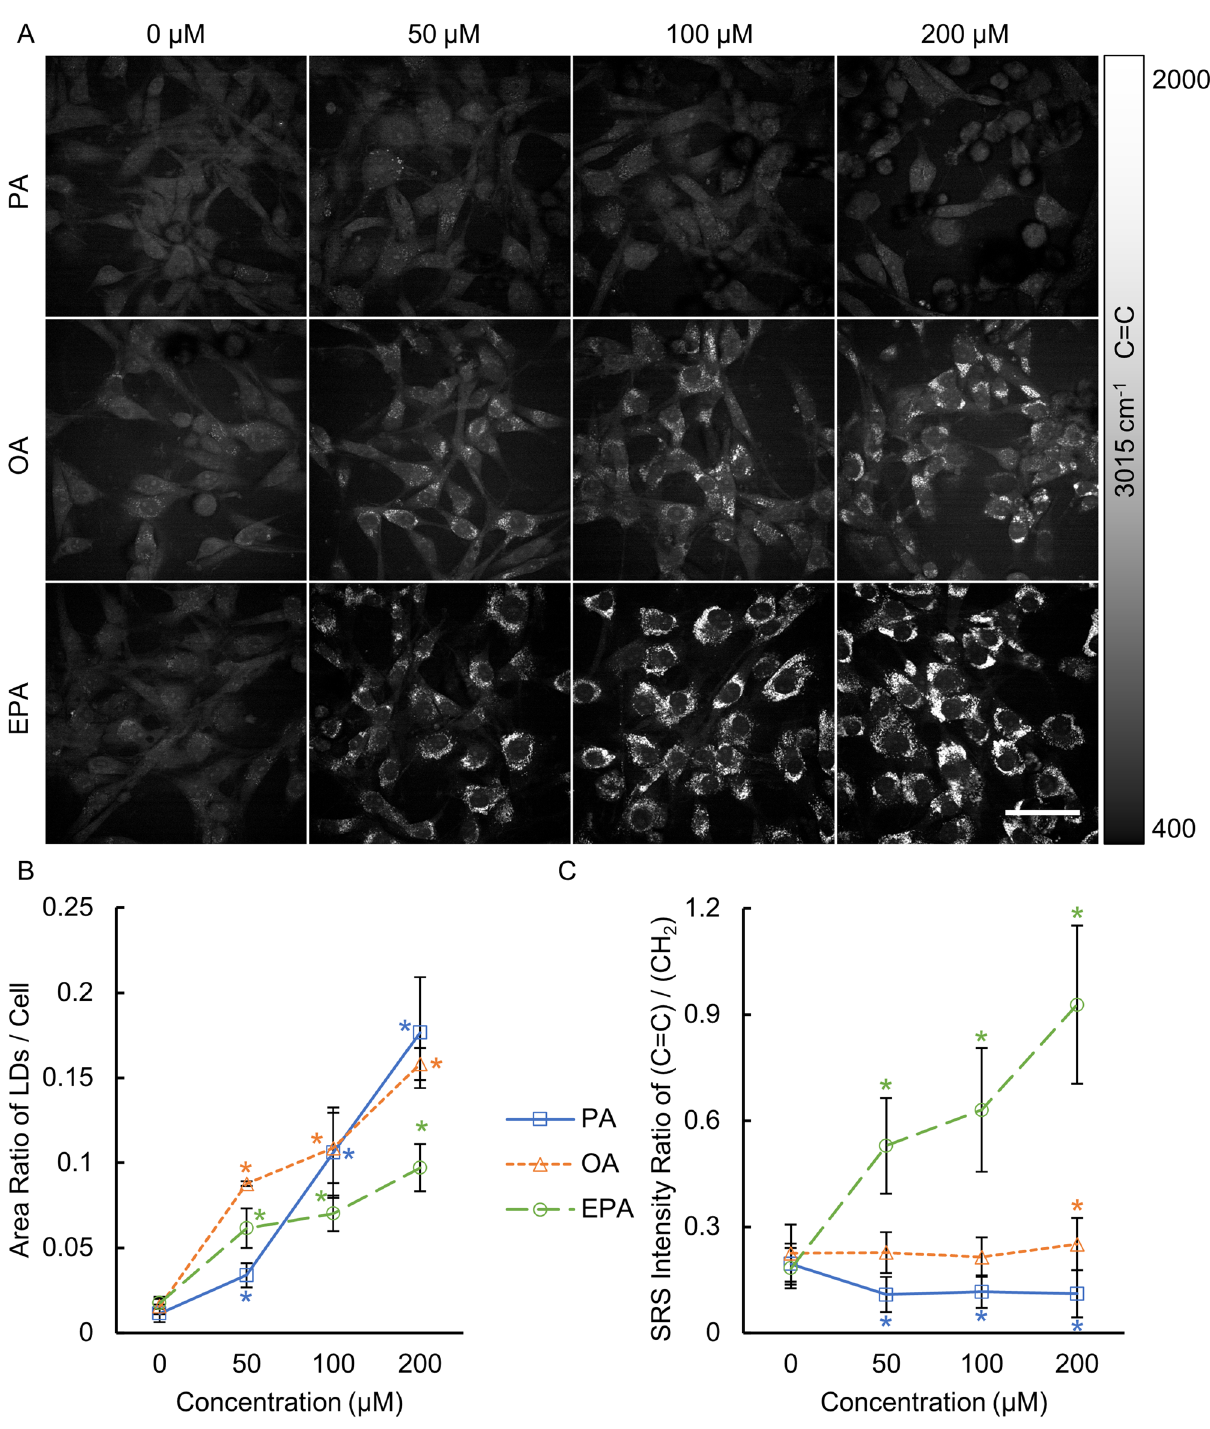
Figure 5. ( A ) SRS images at 3015 cm −1 attributed to C=C vibration with the corresponding fields of view as in Fig. 4. U87 glioma cells were treated with PA, OA, and EPA, respectively, at different concentrations (0, 50, 100, 200 μM) for 24 h. Scale bar, 50 μm. ( B ) Quantification of total lipids in the LDs using the area-ratio method with SRS images at 2854 cm −1 . ( C ) Quantification of the relative unsaturation level of lipids in LDs with SRS images at 2854 cm −1 and 3015 cm −1 . *P < 0.05, the difference is statistically significant from 0 µM (the untreated control group) for all PA-, OA-, and EPA-treated